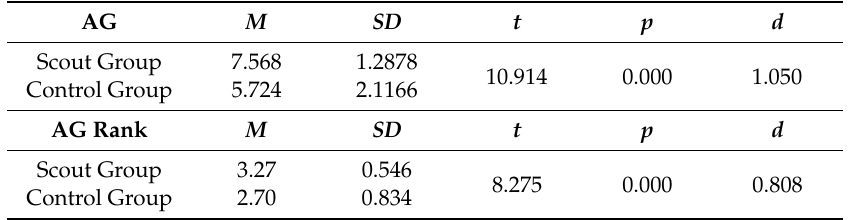
Table 3. t -test to compare academic performance between Scout and non-Scout